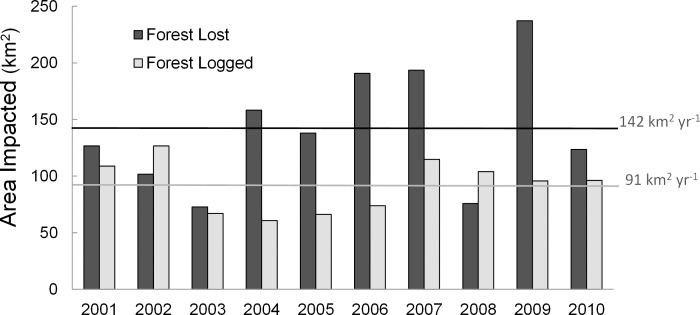
Extent of forest loss and legal selective logging through time (2001–2010) in Berau.Black and grey lines represent mean annual forest loss and forest logged, respectively. There was not a significant linear trend for either forest loss or for logging activity during this ten year period (P>0.05).